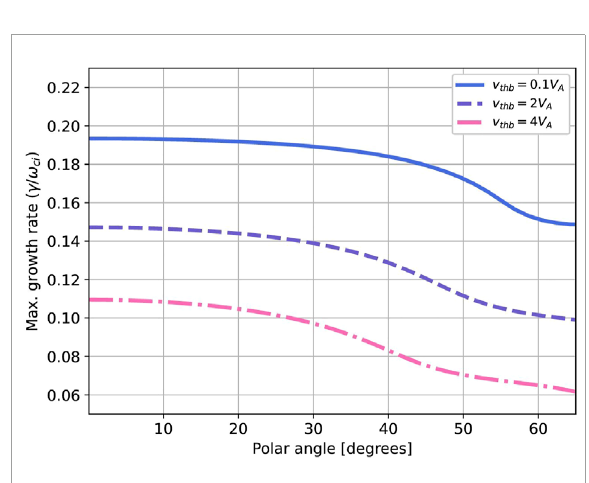
FIGURE 5 Growth rate of the RHI for oblique propagation as a function of the angle between the wave vector k and the background magnetic field for n b / n 0 = . 015 and M A = 10. Note that the growth rate is very similar for angles ≲ 35 ° . The three curves show the growth rate for different beam temperatures with thermal speeds indicated in the